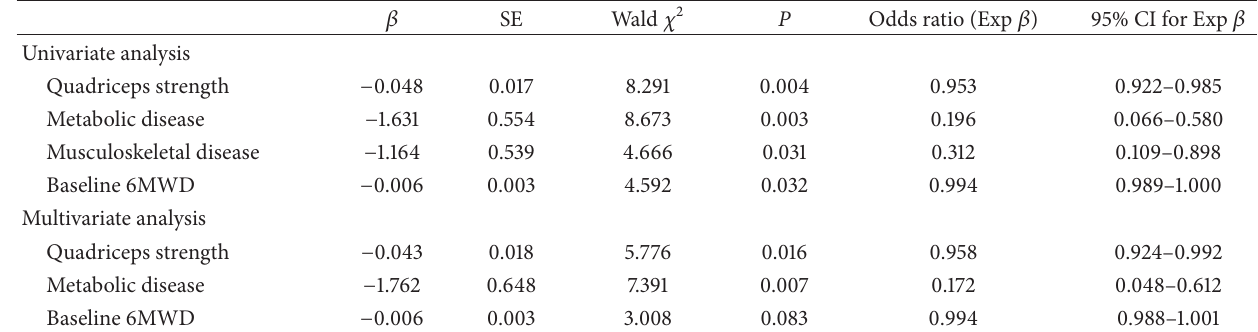
Multivariate analysis